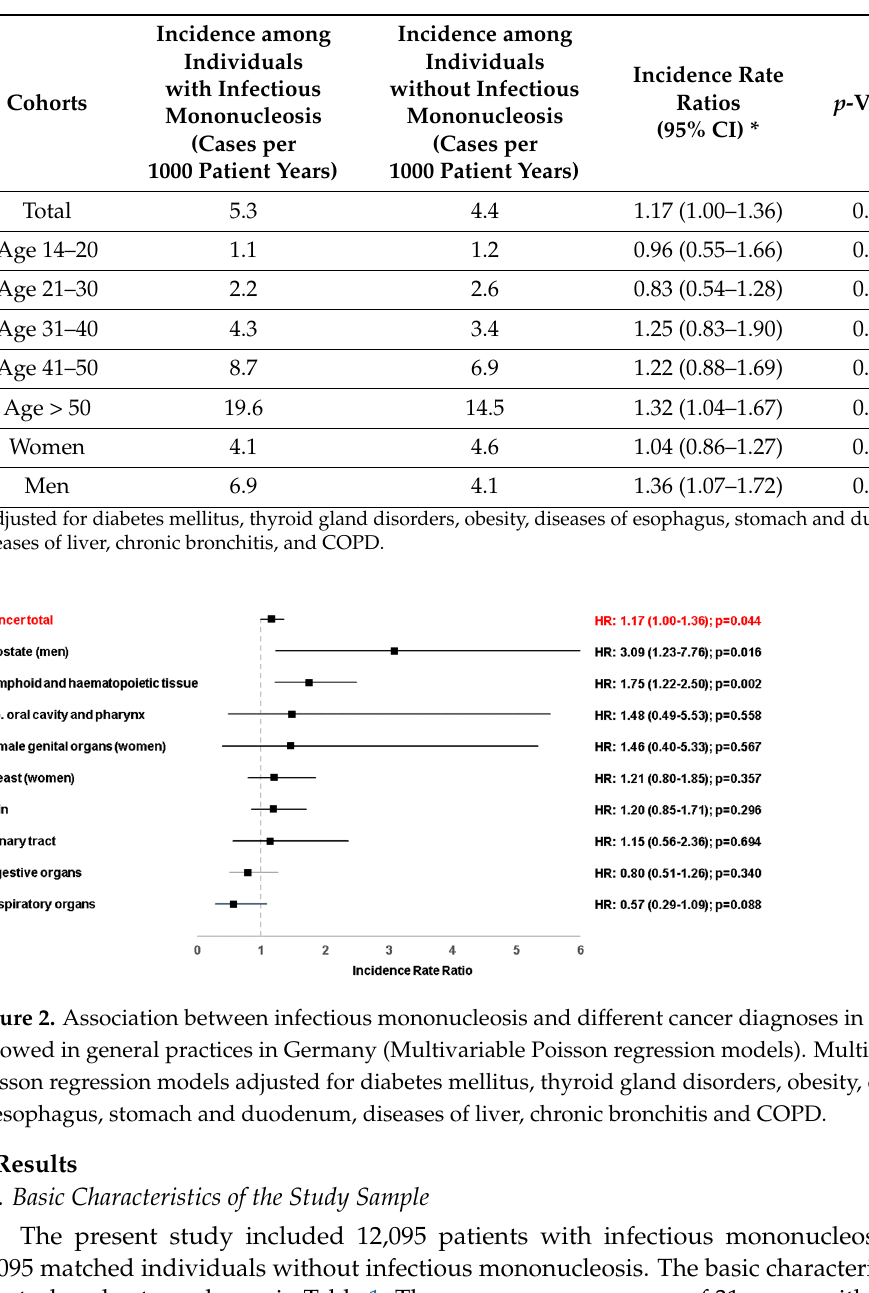
Table 1. Association between infectious mononucleosis and the subsequent cancer diagnoses in patients followed in general practices in Germany (Multivariable Poisson regression model).